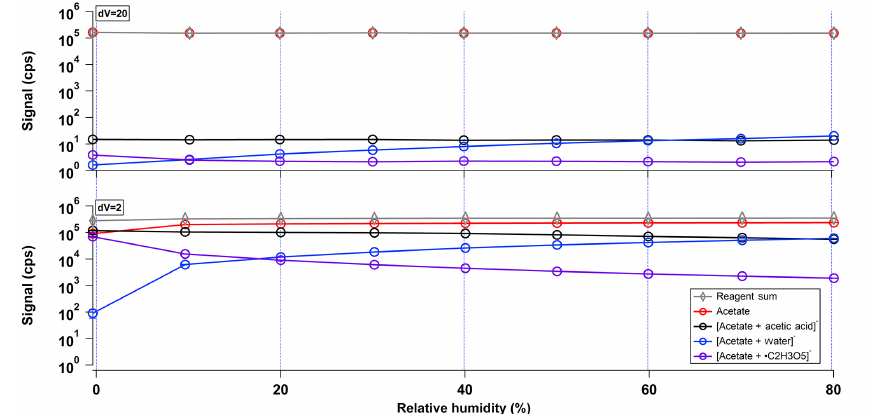
Figure 5. The effect of water vapor on various reagent ions is shown under two voltage settings, dV = 2 (clustered) and dV = 20 (declustered), at component relation